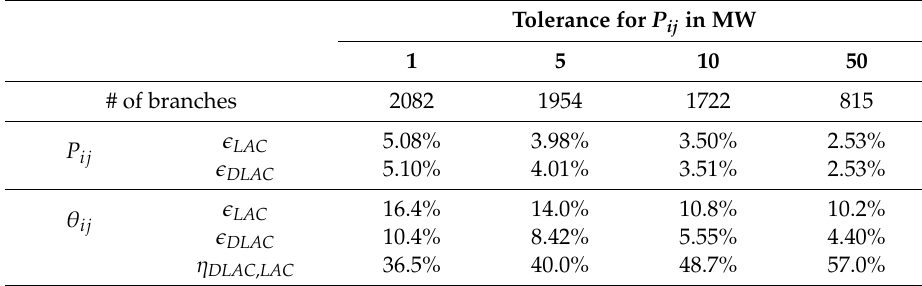
Table 10. Results of Active Power with DLAC and LAC for Hour 2 Case.